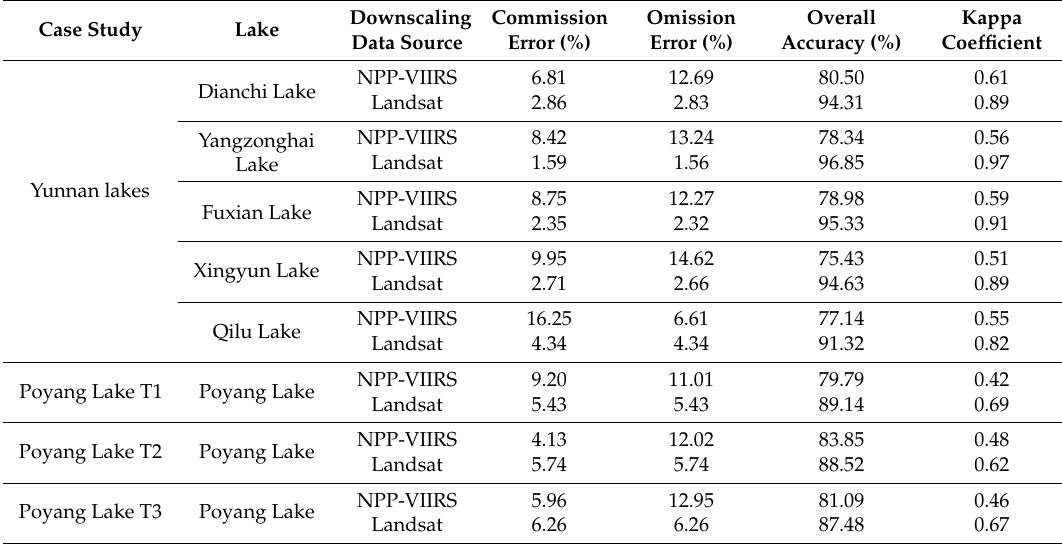
Table 5. Accuracy indices showing the evaluation result of different lakes on both the NPP–VIIRS and Landsat downscaling results for different case